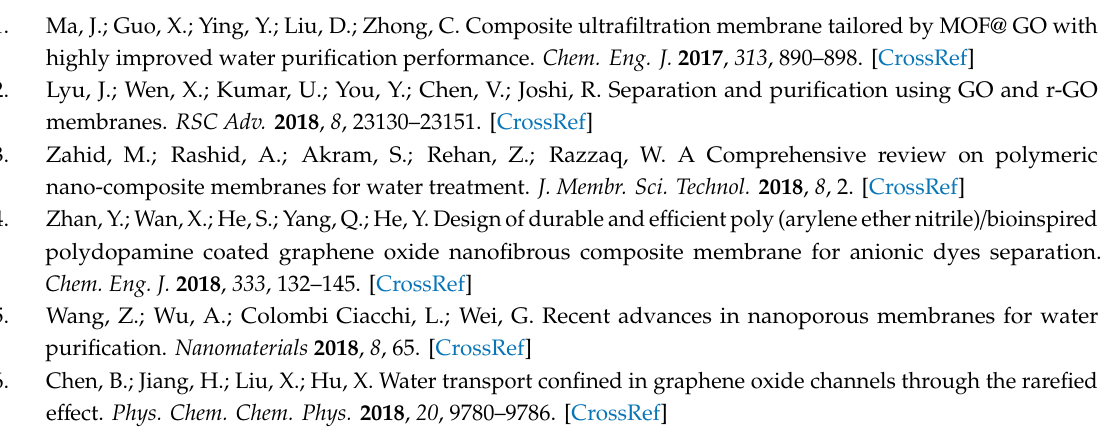
Figure S1: Fourier transform infrared spectroscopy (FTIR) spectrum of graphite and GO, Figure S2: Raman spectra of graphite and GO, Figure S3: photograph of methyl orange decolorization using nonwoven / PVDF-PAA and nonwoven / PVDF-PAA / GO composite membrane, Figure S4: photograph of folic acid decolorization using nonwoven / PVDF-PAA and nonwoven / PVDF-PAA / GO composite